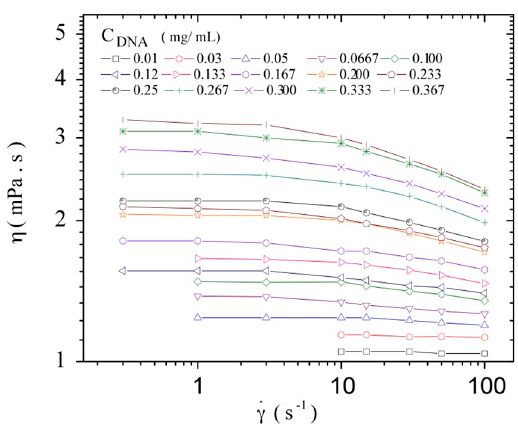
Figure 4. Steady state viscosity as a function of the shear rate for different C DNA at 20 °C in TE buffer.